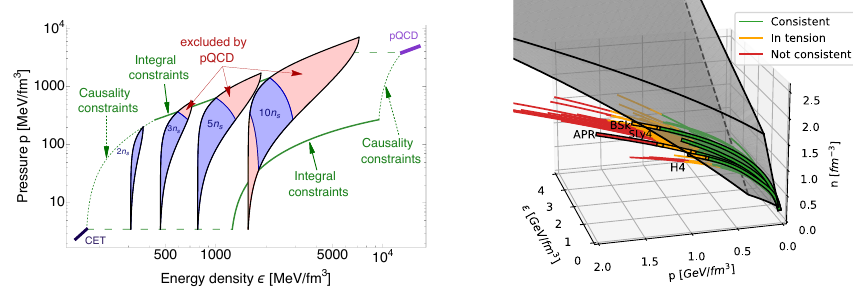
Figure 3. Robust equation-of-state constraints from [22]. (Left) Regions of allowed values of energy density (cid:15) and pressure p for fixed baryon number densities n = 2 , 3 , 5 and 10 n s . At five saturation densities, the QCD input removes 75% of the otherwise allowed values of (cid:15) - p (note the log-scale in fig- ure). (Right) Comparison of the robust constraints with a large set of model equations of state from the ComPOSE database. Nearly all models violate the constraint at some density provided in the database. Equations of states outside the shaded volume are firmly excluded by QCD. Line colours correspond to the renormalization scale uncertainty of the perturbative calculation, for details see the original